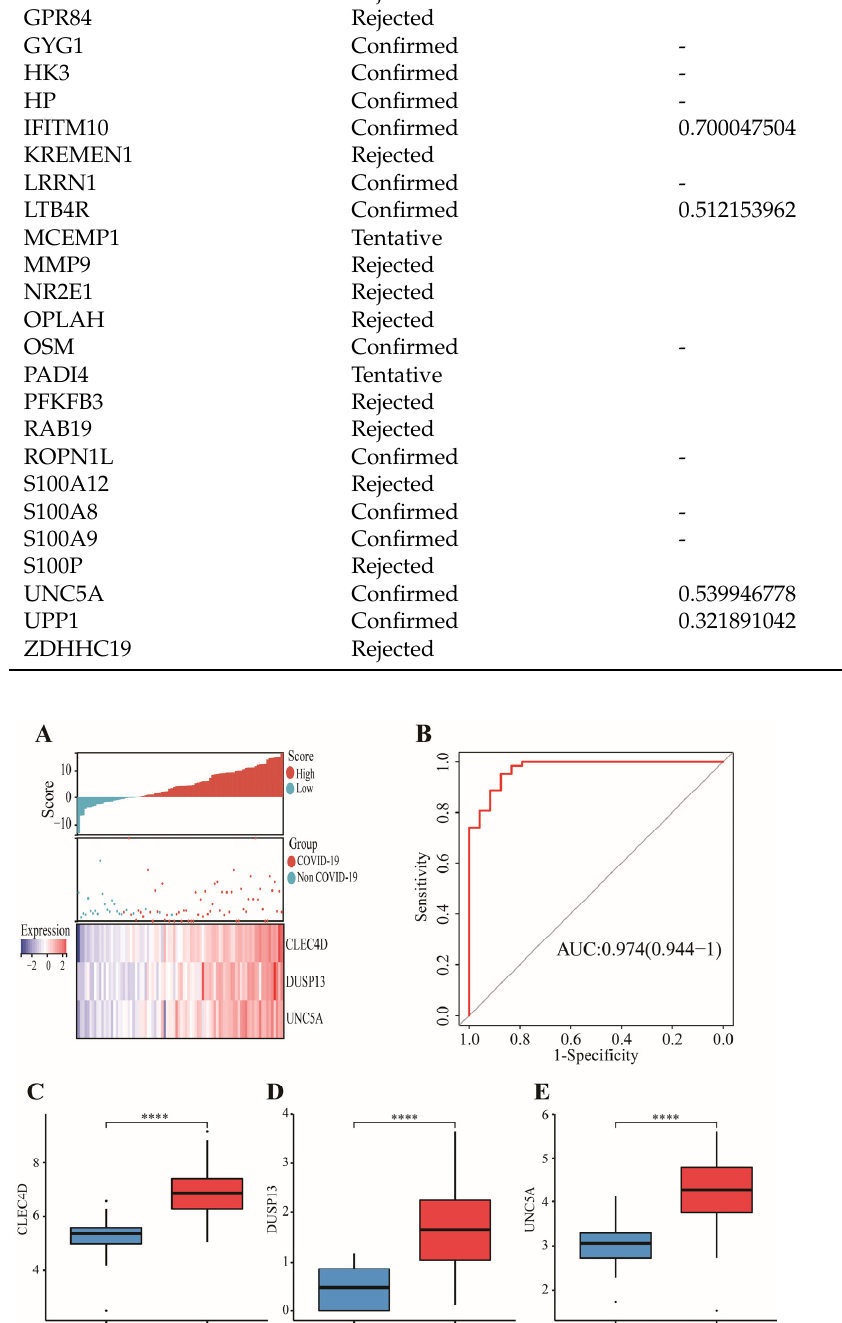
Figure 8. Validation of a 3-gene signature in GSE171110. ( A ) Different outcomes and expressions of CLEC4D, DUSP13, and UNC5A between high- and low-score groups. ( B ) The AUC for prediction of outcome. ( C – E ) The expressions of CLEC4D, DUSP13, and UNC5A between COVID-19 and non- COVID-19 groups. Data in ( C – E ) were analyzed by Wilcoxon test; ns, no significance; **** p < 0.0001.